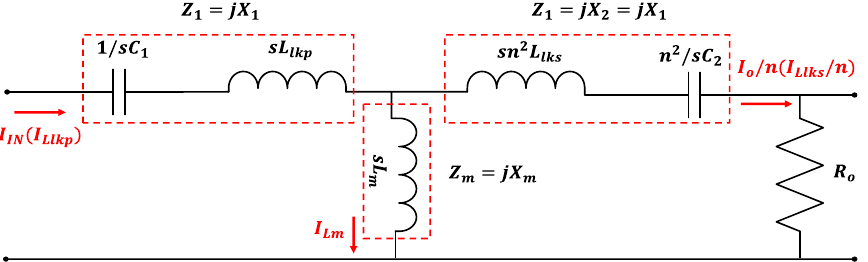
Figure 1. Equivalent circuit of S-S topology.